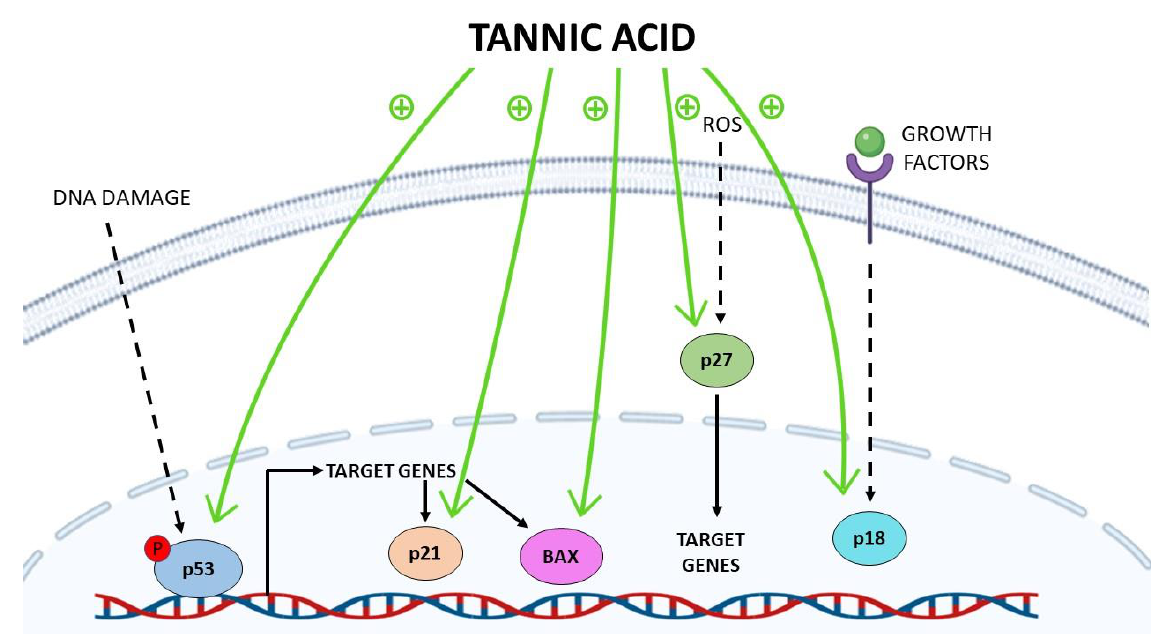
Figure 2. Induction of tumor suppressor proteins by tannic acid (TA). TA enhances the phosphorylation of p53, thereby increasing the expression of its target genes such as p21 and BAX. Moreover, on another level, TA could stimulate both p21 and BAX gene expression directly. TA also stimulates the gene expression of p27 and p18.